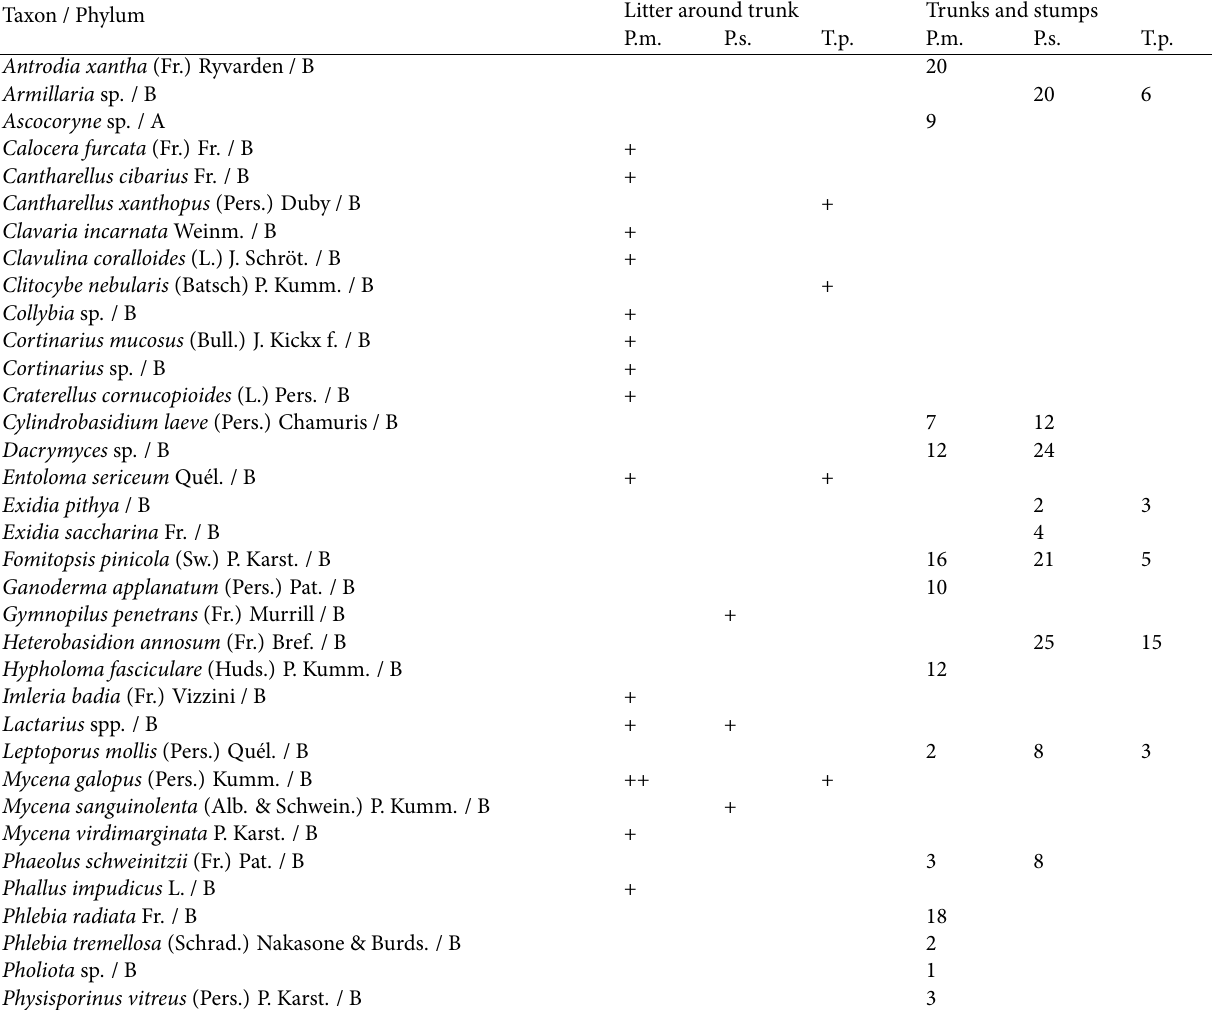
Table 4 Taxa of fungi on the litter layer within a radius of 0.5 m around the trunk and number of sporocarps on trunks and stumps of assessed trees on all